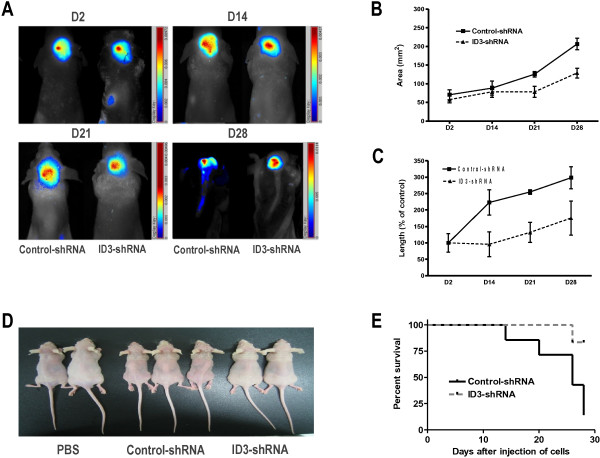
ID3 knockdown by shRNA and inhibition of tumor seeding in vivo. (A) Representative live in vivo imaging of implanted D283 cells transfected with either control-shRNA or ID3-shRNA for 28 days. Note the migration of signals along the spinal cord of a mouse injected with D283-control-shRNA. (B) Serial measurement of tumor-occupied areas in live in vivo imaging. (C) Serial measurement of the longitudinal extent of tumors from the cranium to the spinal canal. (D) Representative gross photos of mice injected with PBS, D283-controlshRNA, and D283-ID3-shRNA. Mice that received D283-control-shRNA (middle photo) show cachexia and scoliosis, signs of tumor seeding along the spinal cord. (E) A Kaplan-Meier survival plot of mice after implantation of D283 cells reveals the increased survival by shRNA. All animals were sacrificed at day 28 for histological examination.